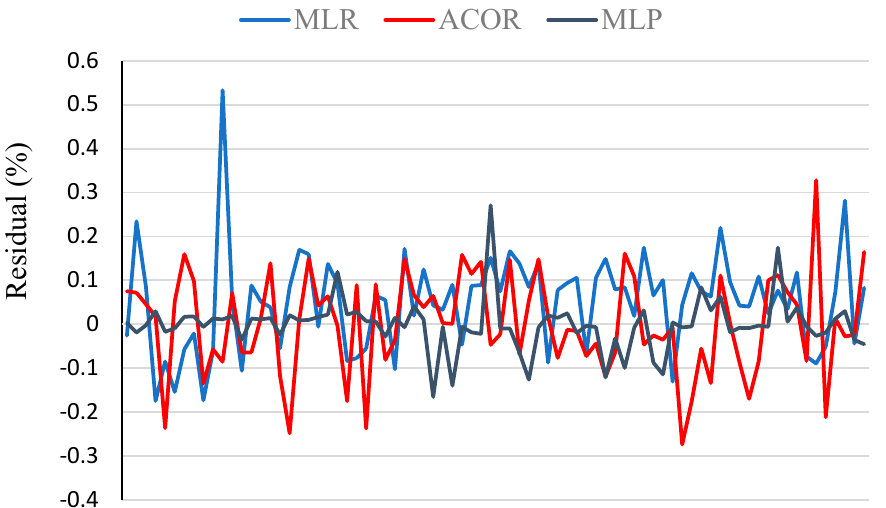
Figure 3. The comparison of the error values estimated by the MLR, ACO R and MLP.